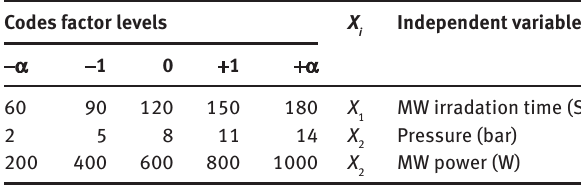
Table 1: Independent variables for central composite design